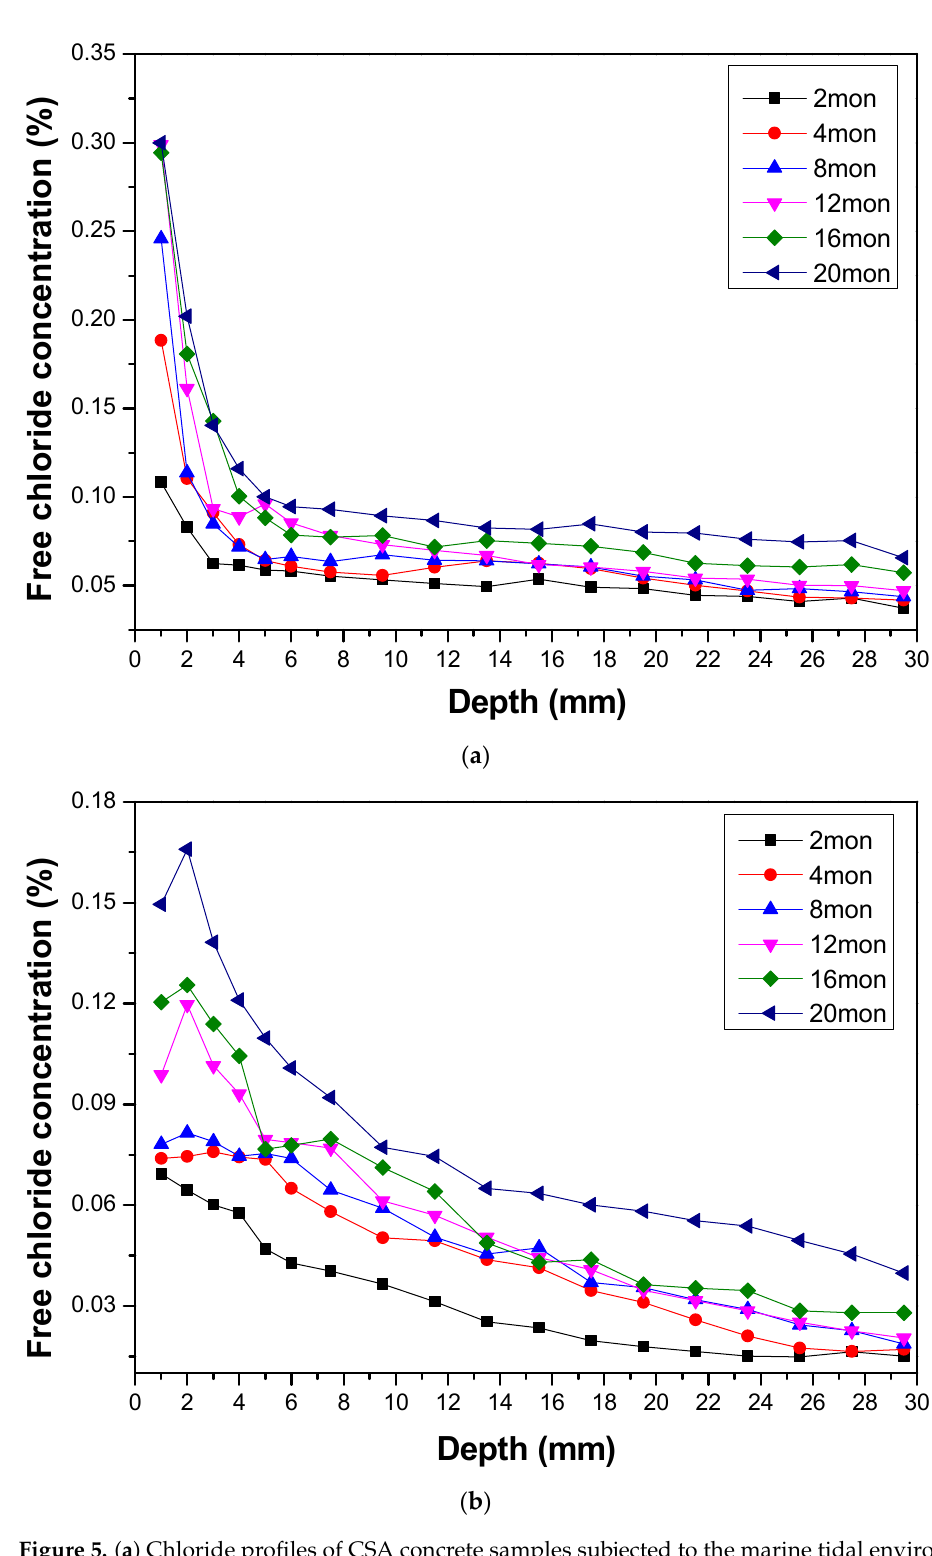
Figure 5. ( a ) Chloride pro fi les of CSA concrete samples subjected to the marine tidal environment. ( b ) Chloride pro fi les of OPC concrete samples subjected to the marine tidal environment. ( b ) Chloride profiles of OPC concrete samples subjected to the marine tidal